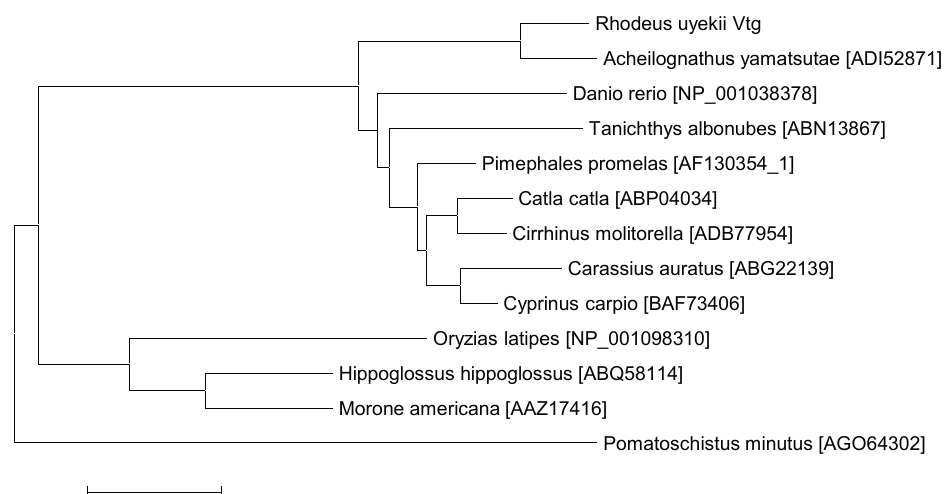
Figure 2. Phylogenetic analysis of Vg family members. An unrooted phylogenetic tree was constructed using the neighbor-joining method. The sequences were extracted from GenBank. The accession numbers are indicated in the